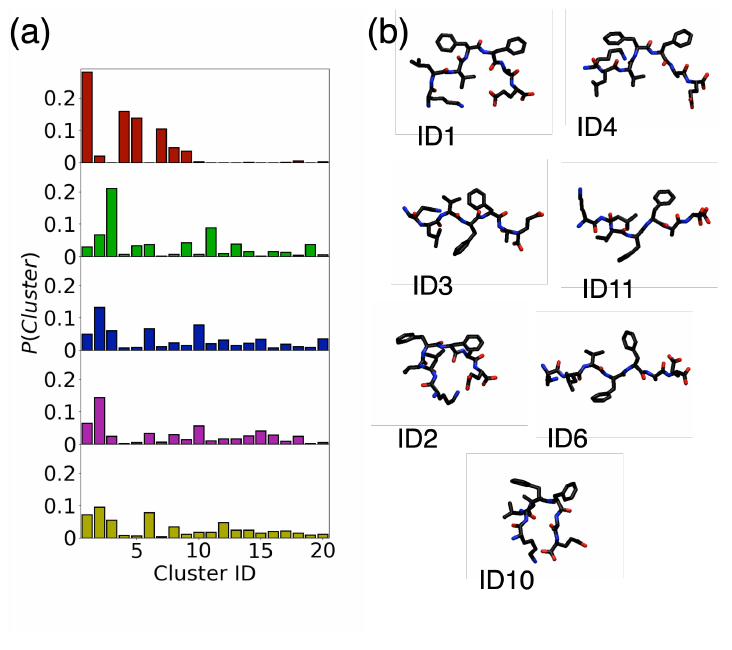
Figure 8. ( a ) Probability of highest ranked clusters for (top to bottom) Au111, Au100, Ag111, Ag100, and bulk solution; ( b ) snapshots of selected conformations found from the combined cluster